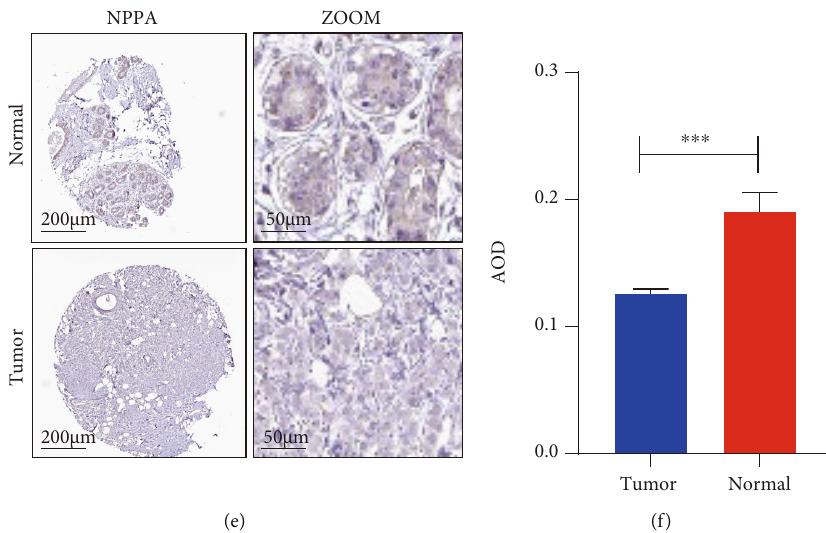
Figure 3: The expression of NPPA was impaired in breast cancer tissues. (a – c) The expression pattern of NPPA in IST Online (a), GEPIA (b), or in TCGA (c). (d) The expression of NPPA mRNA in tumor and paratumor tissues (A), in di ff erent PAM50 subtypes (B), and in GSE65216 database (C). (e, f) The expression (e) and quanti fi cation (f) of NPPA protein level in the Human Protein Atlas with immunohistochemistry. Average optical density (AOD) was used to determine the protein level of NPPA. For the data in (d), (A) was analyzed with paired Student ’ s t -test and the rest were analyzed with Student ’ s t -test. ∗ p < 0 : 05 , ∗∗ p < 0 : 01 , and ∗∗∗ p < 0 : 001